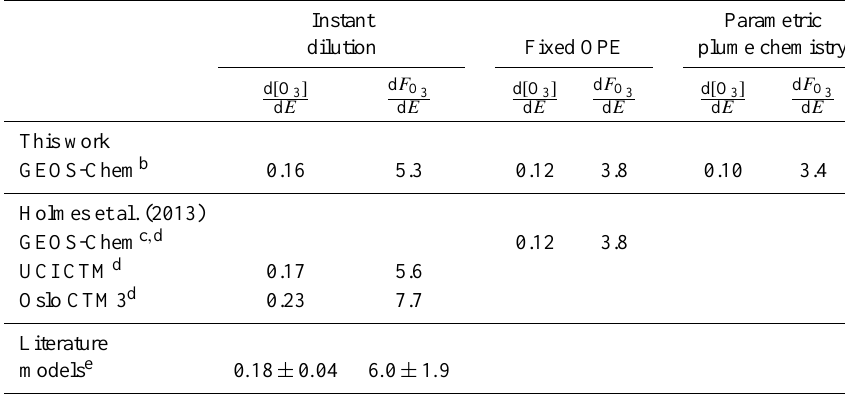
Table 2. Effect of ship-NO x emissions on O 3 column and RF a